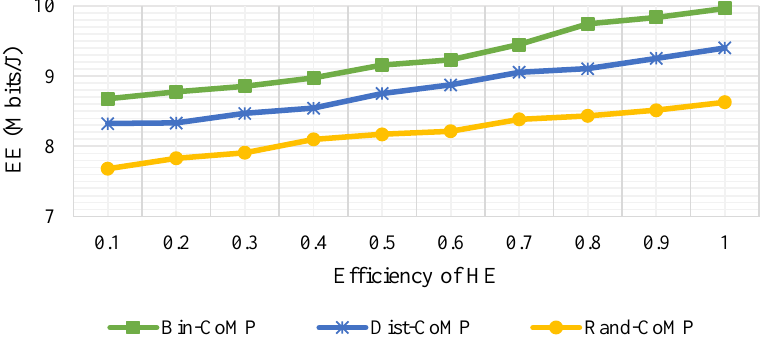
Figure 9. Impact of the efficiency of HE on the EE of the system analysed for diverse BS-Sw methods = 10 dB and E HC = 2 with E HC M S